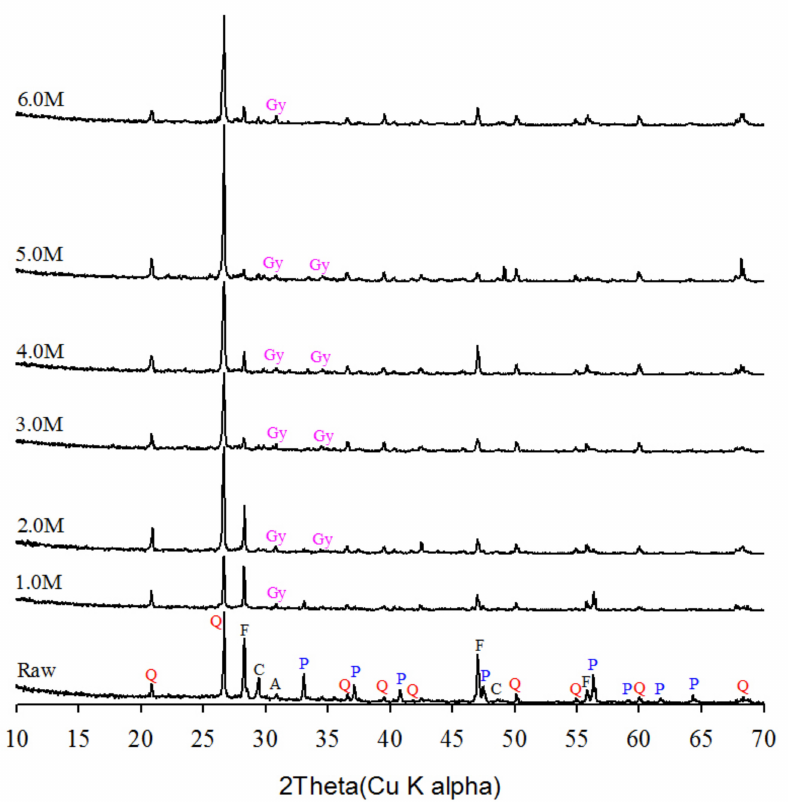
Figure 7. Comparative XRD patterns of raw concentrate and leach residue after microwave-nitric acid leaching as a function of nitric acid concentration. A: adularia; C: calcite; F: fluorspar; P: pyrite; Q: quartz and Gy: gypsum. Leaching conditions: HNO 3 Concentration; 1.0 to 6.0 M, reaction time; 15